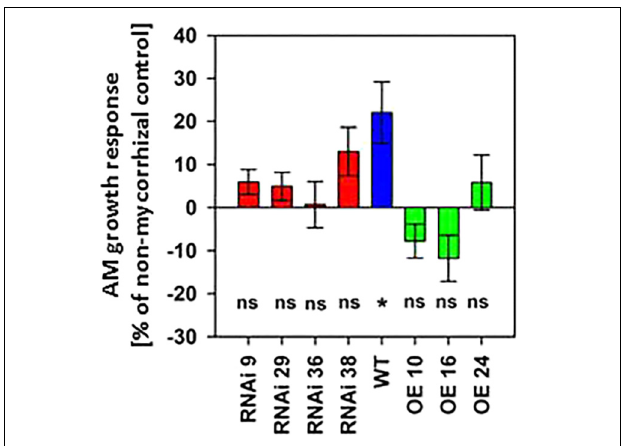
FIGURE 4 | Total biomass production of NtMSBP1 -RNAi and MSBP1 -overexpressing tobacco lines compared to non-mycorrhizal control plants. Mean values and standard deviations are shown for six replicates of mycorrhizal and non-mycorrhizal wild type plants and of NtMSBP1-RNAi and MSBP1 -overexpressing lines. Whether the growth AM response is different from zero was tested by ANOVA ( n = 6, P <